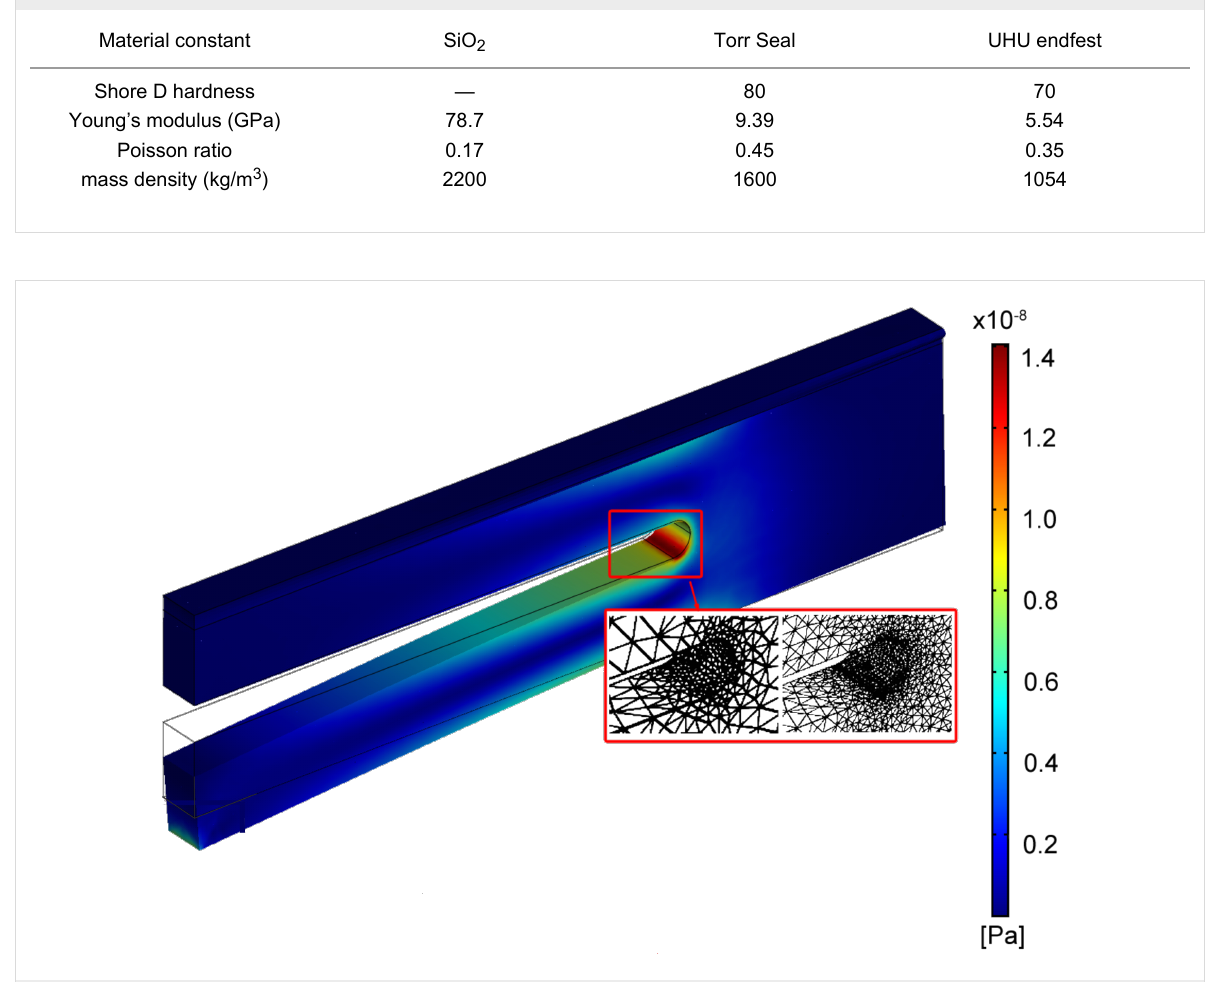
Table 3: Material constants used for FEM simulations. The quartz parameters are taken from COMSOL’s material library, except the Young’s modulus, which was taken from [21]. The glue parameters are taken from [28-30], while the Young’s modulus thereof was determined by converting the Shore D strength using [31].